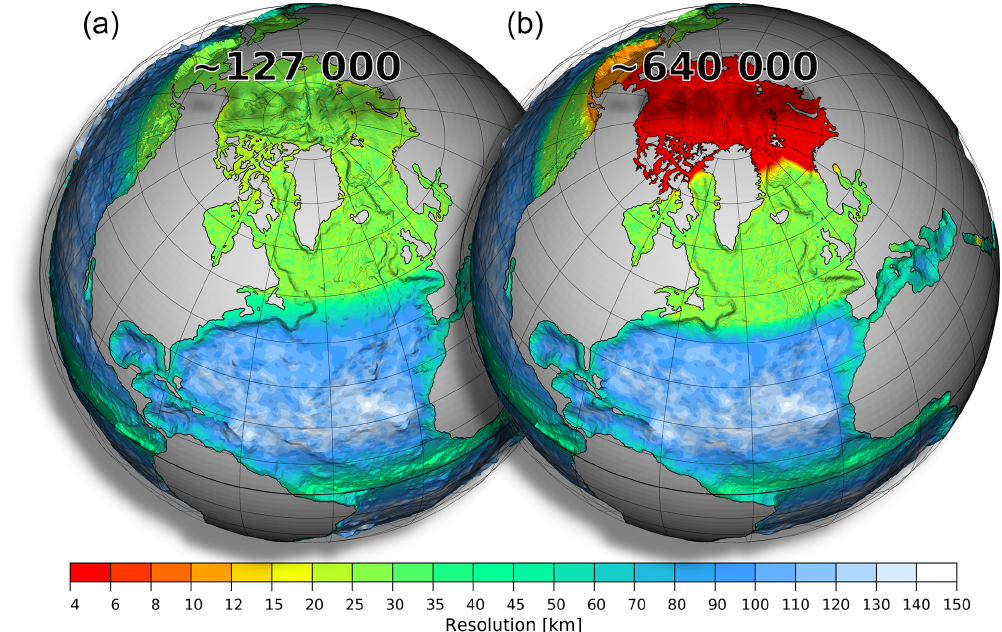
Figure 1. Horizontal resolution of mesh configurations used in this study: smaller reference ( a , ∼ 127000 surface vertices) and larger medium-sized ( b , ∼ 640000 surface vertices) meshes. The two meshes have the same resolution (nominal resolution of 1 ◦ in most parts of the global ocean, ∼ 25km north of 50 ◦ N, ∼ 1/3 ◦ at the Equator) except for the Arctic Ocean and Bering Sea. There, the medium-sized mesh has an increased resolution of 4.5km and 10km for the Arctic Ocean and Bering Sea,